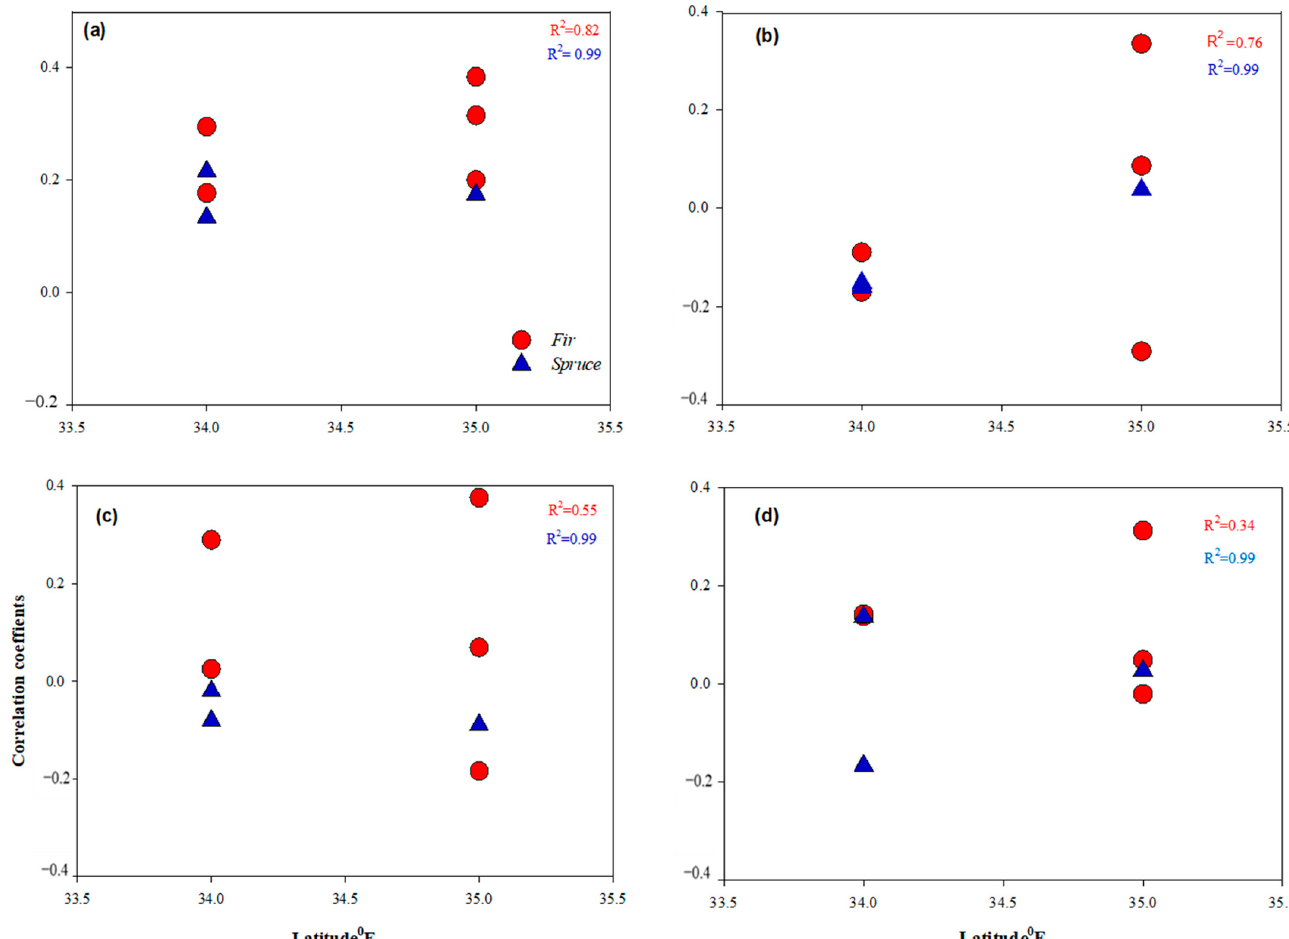
Figure 9. Variation of correlation coefficients between the tree-ring chronologies of spruce (blue triangles) and fir (red dots) and seasonal temperature with latitudes during 1950–2018. ( a ) Winter (Dec–Feb), ( b ) spring (Mar–May), ( c ) summer (Jun–Jul), and ( d ) autumn (Sep–Nov).